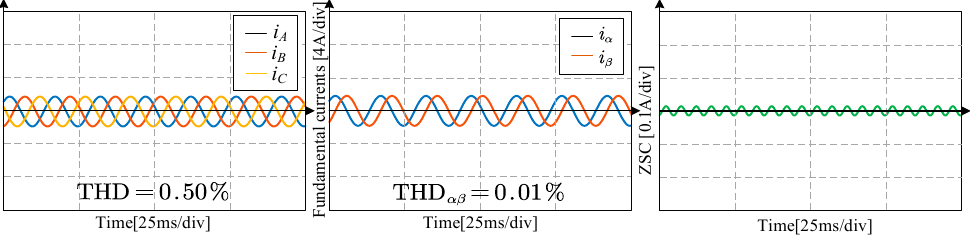
Figure 16. Simulation steady-performance of proposed FW-DFVL under 800 rpm reference.